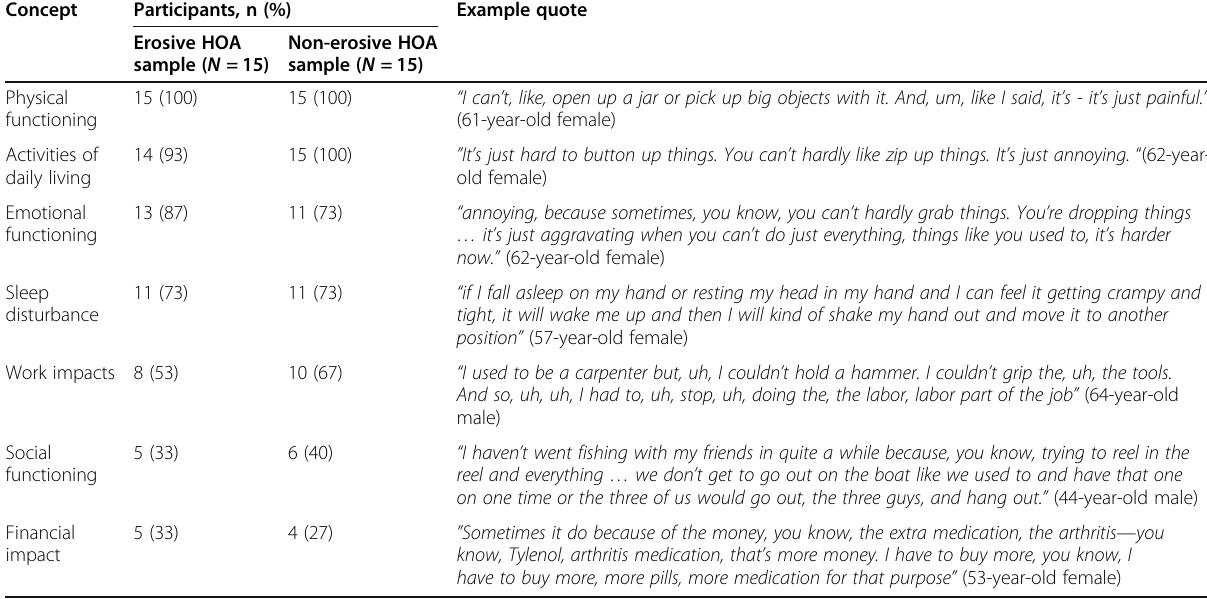
Table 3 Summary of impacts reported in the concept elicitation interviews